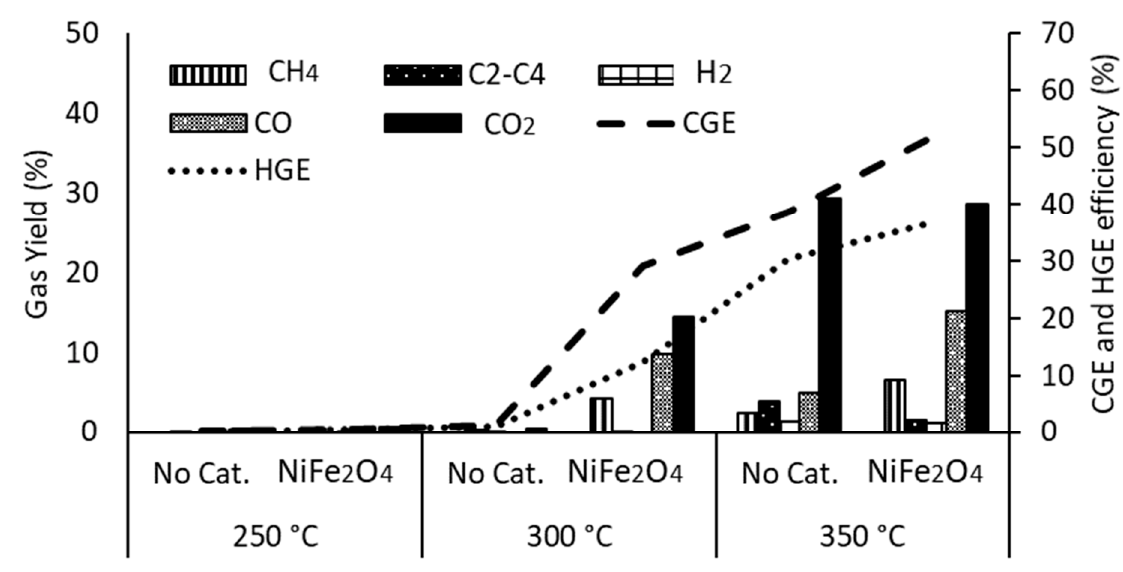
Figure 3. Effect of temperature on catalytic reforming of glycerol without and with the NiFe 2 O 4 cat ‐ alyst.